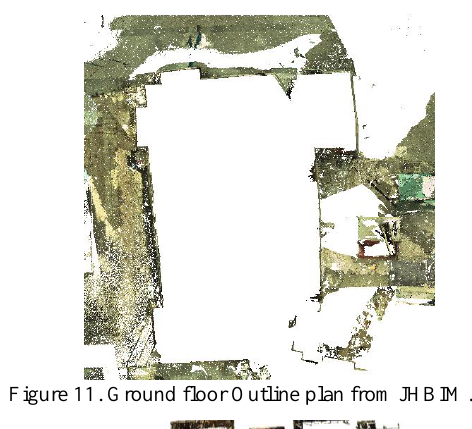
Figure 10. East Elevation from JHBIM.